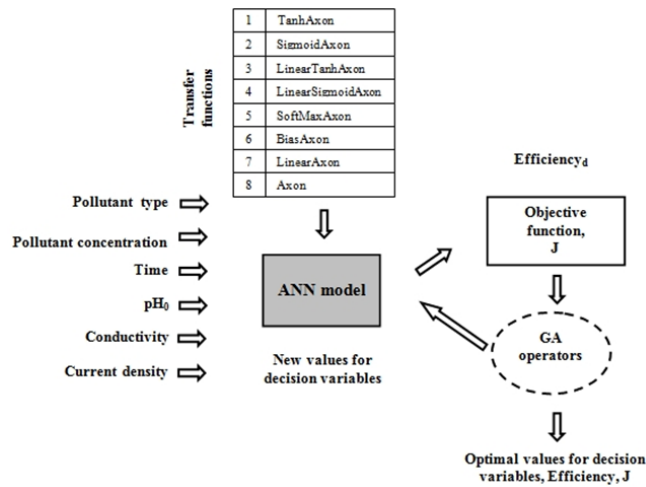
Figure 5. Optimization strategy based on ANN-GA methodology. Table 1. Optimizations performed with different values of GA control parameters for kaolin.